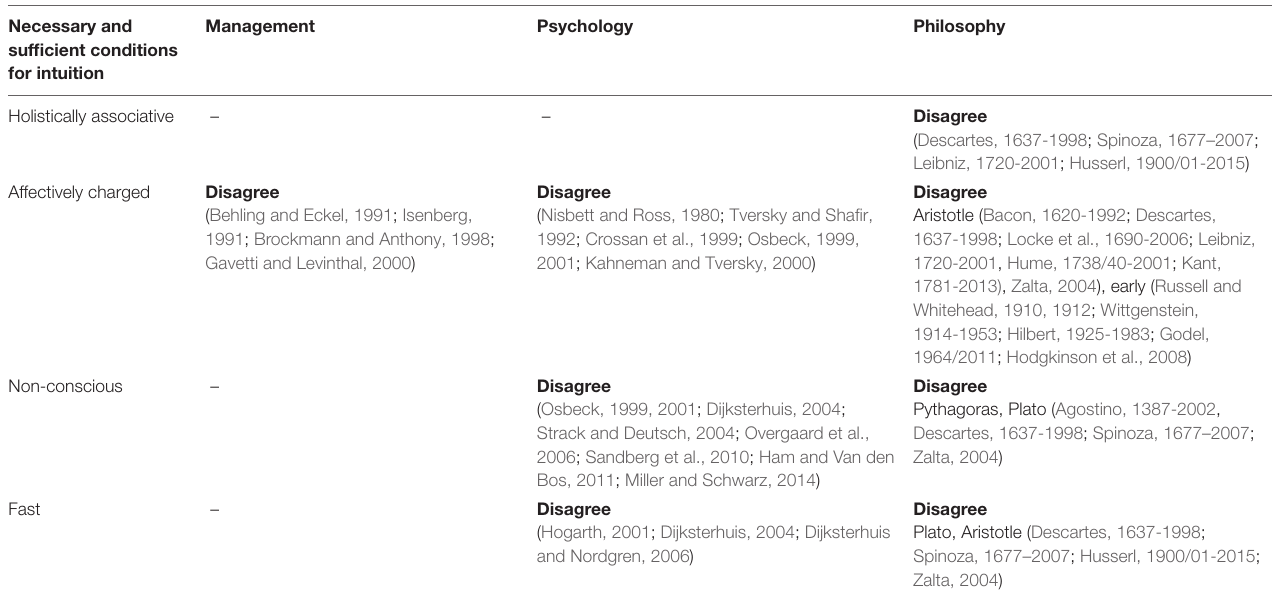
TABLE 2 | Sources that disagree with the proposed attributes of